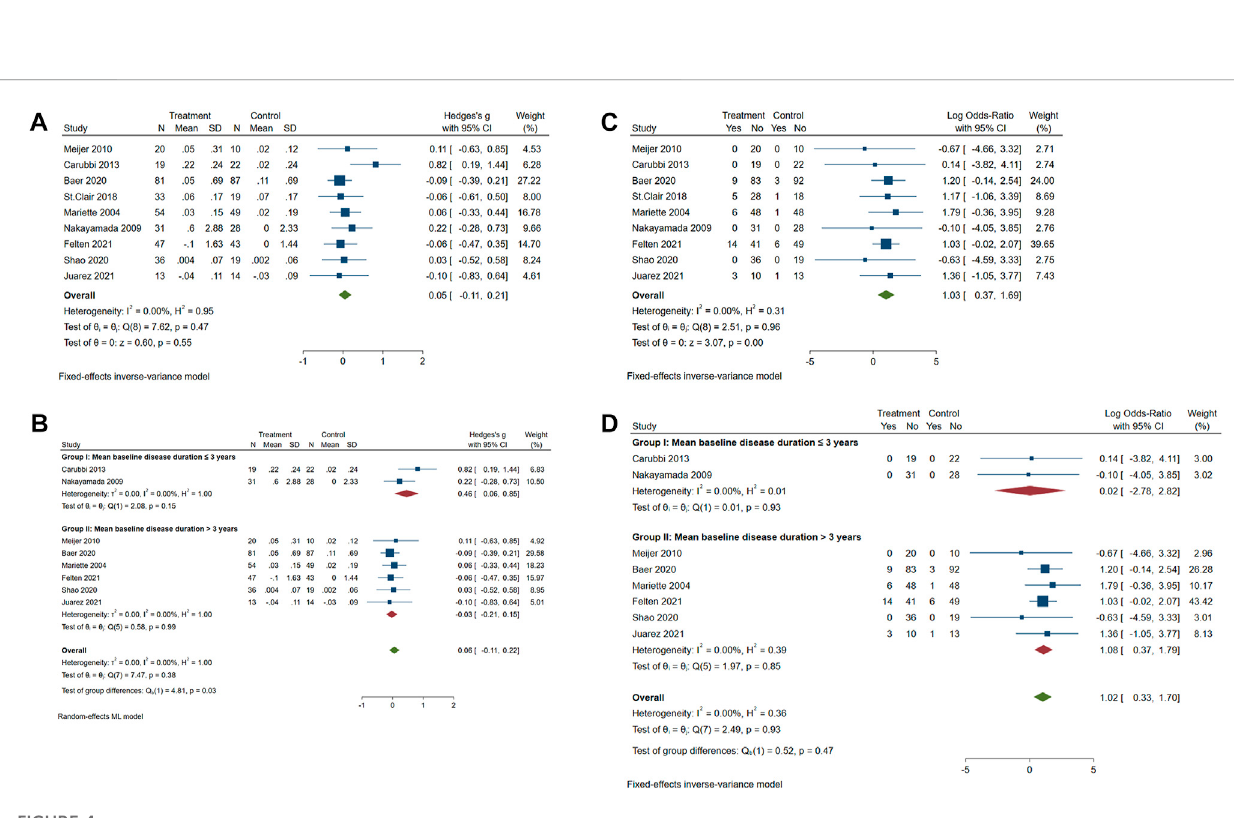
As shown in Figure 4C, SAEs were reported in fi ve studies. A